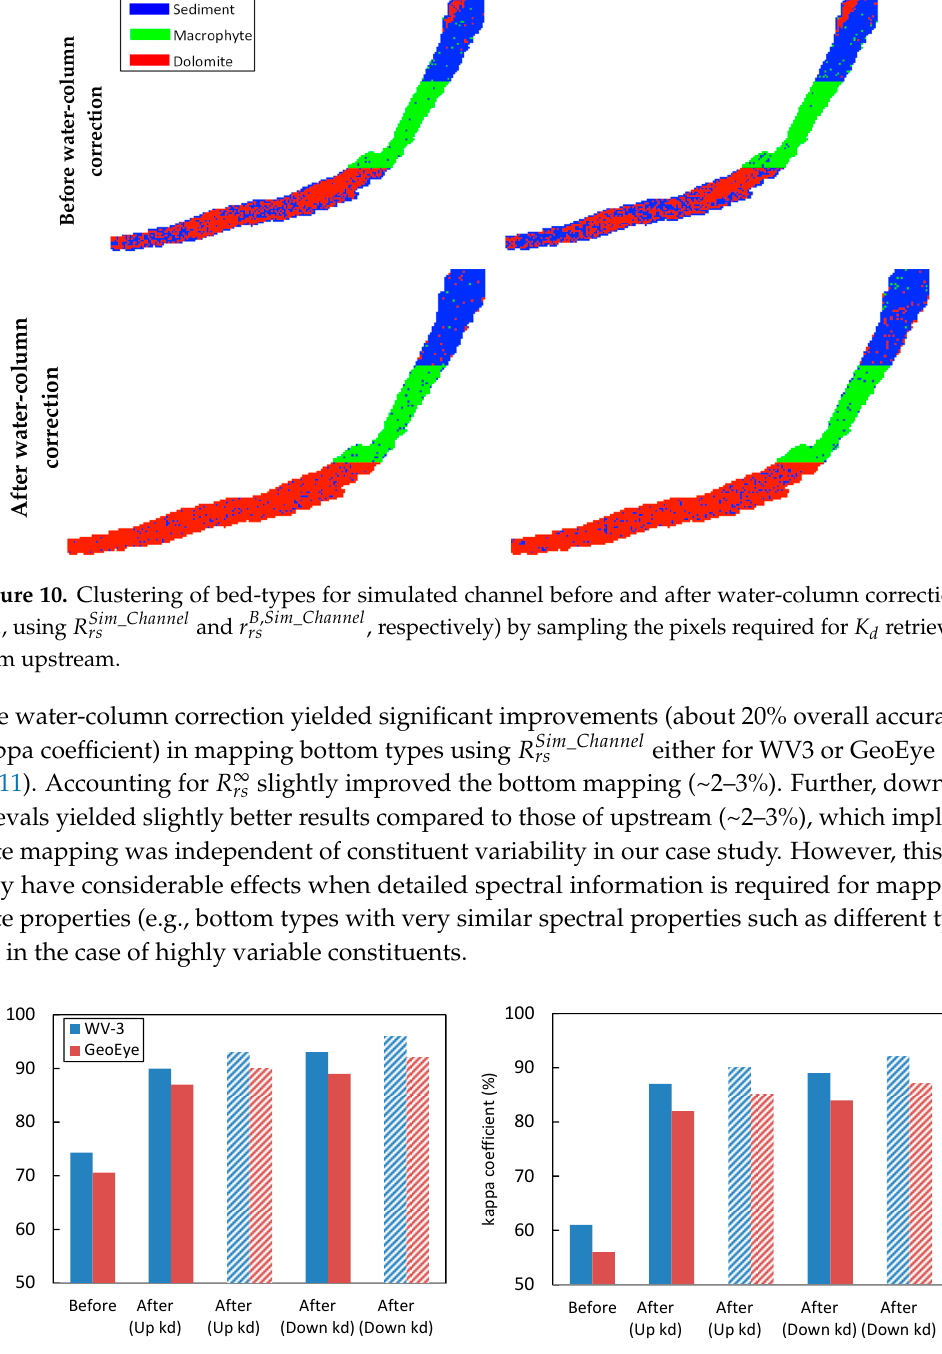
13 of 22 Figure 8. Retrievals of 𝐾 (cid:3031) for the simulated river channel (a) without and (b) with accounting for 𝑅 (cid:3045)(cid:3046)(cid:2998) compared to the reference 𝐾 (cid:3031)(cid:3020)(cid:3036)(cid:3040)_(cid:3004)(cid:3035)(cid:3028)(cid:3041)(cid:3041)(cid:3032)(cid:3039),(cid:3024)(cid:3023)(cid:2871) . Note that constituents assigned to the downstream area were more representative for the entire simulated stream. Therefore, as expected, downstream estimates of 𝐾 (cid:3031) were more in agreement with the reference 𝐾 (cid:3031)(cid:3020)(cid:3036)(cid:3040)_(cid:3004)(cid:3035)(cid:3028)(cid:3041)(cid:3041)(cid:3032)(cid:3039) (Figure 8) than that of the upstream retrievals, particularly when 𝑅 (cid:3045)(cid:3046)(cid:2998) was not taken into account. Figure 9 shows the RMSEs for upstream and downstream 𝐾 (cid:3031) retrievals with and without applying deep-water correction. Considering 𝑅 (cid:3045)(cid:3046)(cid:2998) led to improvements in deriving 𝐾 (cid:3031) , particularly for the upstream-based retrieval. Figure 9. Performance of 𝐾 (cid:3031) retrievals expressed in terms of RMSE (1/m) using (a) 𝑅 (cid:3045)(cid:3046)(cid:3020)(cid:3036)(cid:3040)_(cid:3004)(cid:3035)(cid:3028)(cid:3041)(cid:3041)(cid:3032)(cid:3039),(cid:3024)(cid:3023)(cid:2871) and (b) 𝑅 (cid:3045)(cid:3046)(cid:3020)(cid:3036)(cid:3040)_(cid:3004)(cid:3035)(cid:3028)(cid:3041)(cid:3041)(cid:3032)(cid:3039),(cid:3008) by sampling the depths from upstream and downstream of the simulated channel with (WD) and without (WoD) accounting for deep-water reflectance 𝑅 (cid:3045)(cid:3046)(cid:2998) .